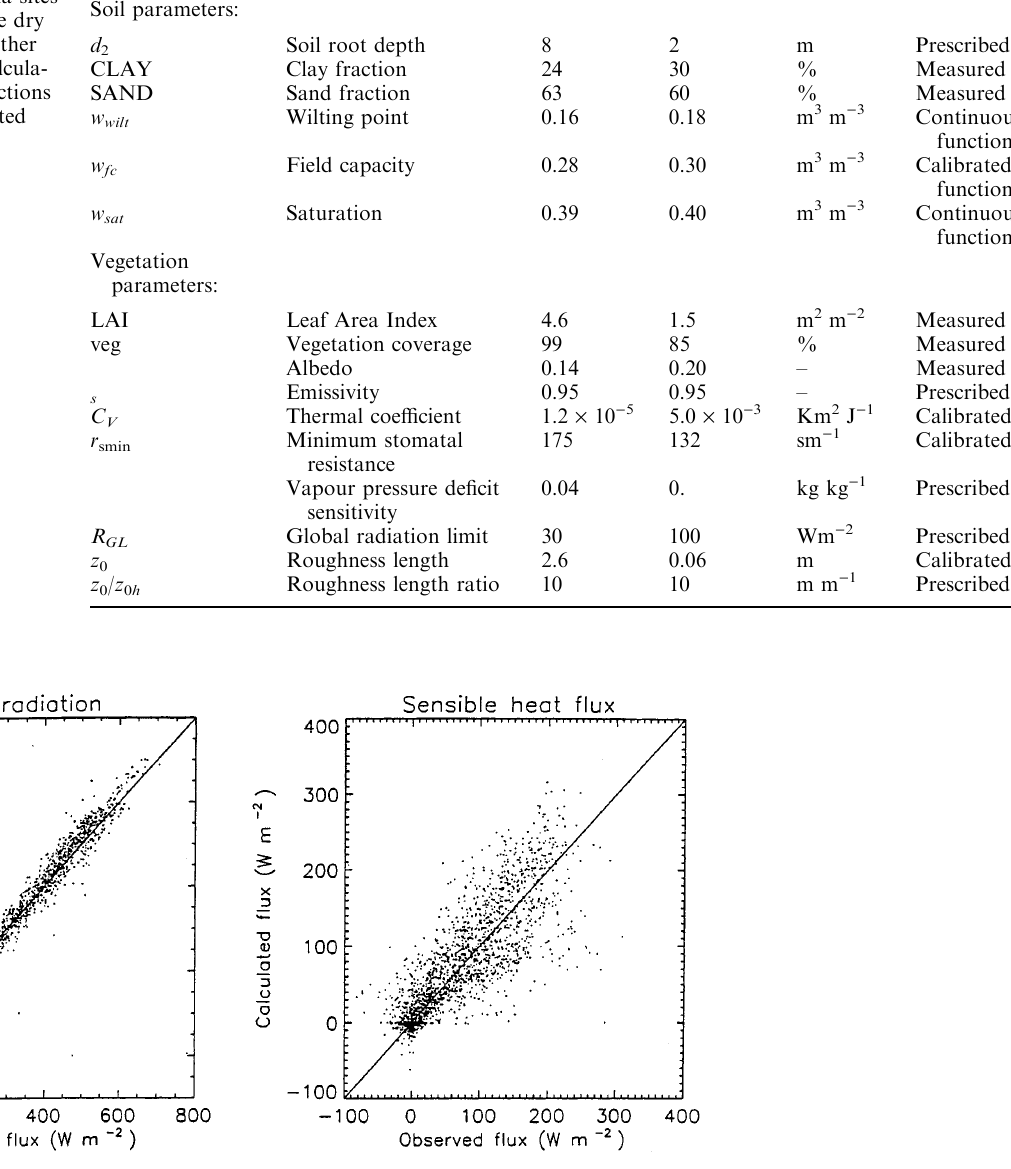
Table 3. The ISBA scheme soil and vegetation structure para- meters over the Rondoˆ nia sites of ABRACOS during the dry season. The values are either prescribed, measured, calcula- ted from continuous functions of the texture, or calibrated